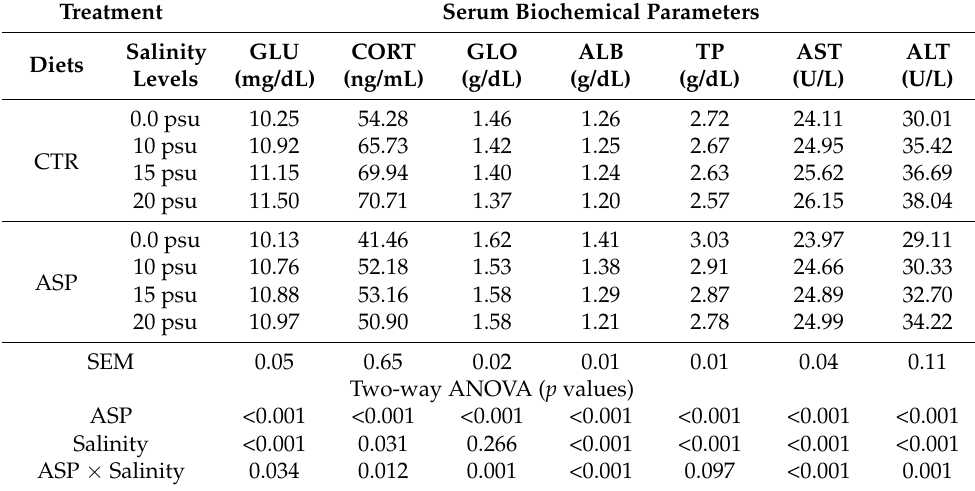
Table 1. Serum biochemical measurements of Nile tilapia fed a basal diet (CTR) compared to those fed on diets supplemented with Aspergillus oryzae (ASP) for 12 weeks and then exposed to different salinity levels for 15 days.